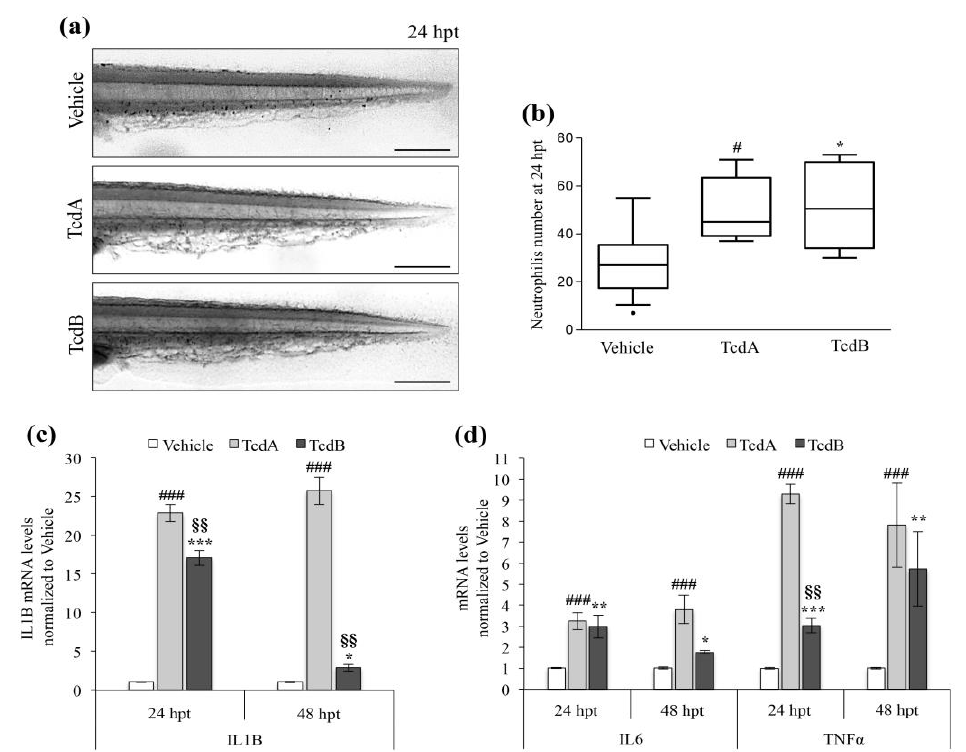
Figure 6. TcdA and TcdB promote the inflammatory response and active the immune system. ( a ) Representative images of Sudan Black staining of neutrophils at 24 hpt in zebrafish embryos treated with vehicle, 2.5 µ g / mL TcdA or 8 µ g / mL TcdB. The pictures are lateral view of the tail. Images were acquired with a Leica S8AP0 stereo microscope. Scale bar = 200 µ m. ( b ) Neutrophils number in embryos treated with toxins (2.5 µ g / mL TcdA or 8 µ g / mL TcdB) or vehicle. Data are represented in a Tukey box and whisker plot, ( n = 20), ( # p < 0.05, * p < 0.05 compared to vehicle). ( c ) qRT-PCR analysis of zebrafish pro-inflammatory cytokine IL1B at 24 and 48 h after the administration of 2.5 µ g / mL TcdA or 8 µ g / mL TcdB. Data, normalized to the β -Actin mRNA amount, are represented as the mean ± SEM. ( n = 9), ( ### p < 0.001, *** p < 0.001 and * p < 0.05 compared to vehicle; §§ p < 0.001 compared to TcdA). ( d ) qRT-PCR analysis of zebrafish pro-inflammatory cytokines IL6 and TNF α at 24 and 48 h after the administration of 2.5 µ g / mL TcdA or 8 µ g / mL TcdB. Data, normalized to the β -Actin mRNA amount, are represented as the mean ± SEM ( n = 9), ( ### p < 0.001, *** p < 0.001, ** p < 0.01, * p < 0.05 compared to vehicle; §§ p < 0.001 compared to TcdA).